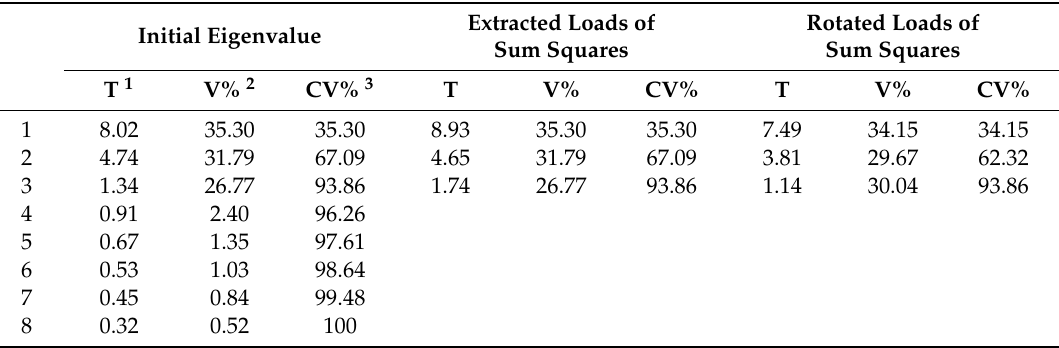
Table 4. Interpretation of total